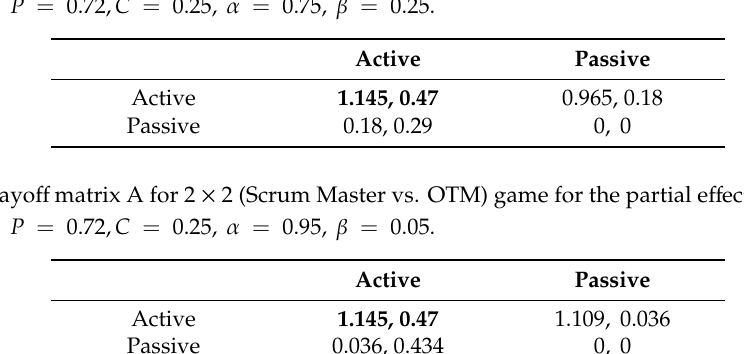
Table 10. Payo ff matrix A for 2 × 2 (Scrum Master vs. OTM) game for the partial e ff ective team with L = 0.675, P = 0.72, C = 0.25, α = 0.75, β = 0.25.